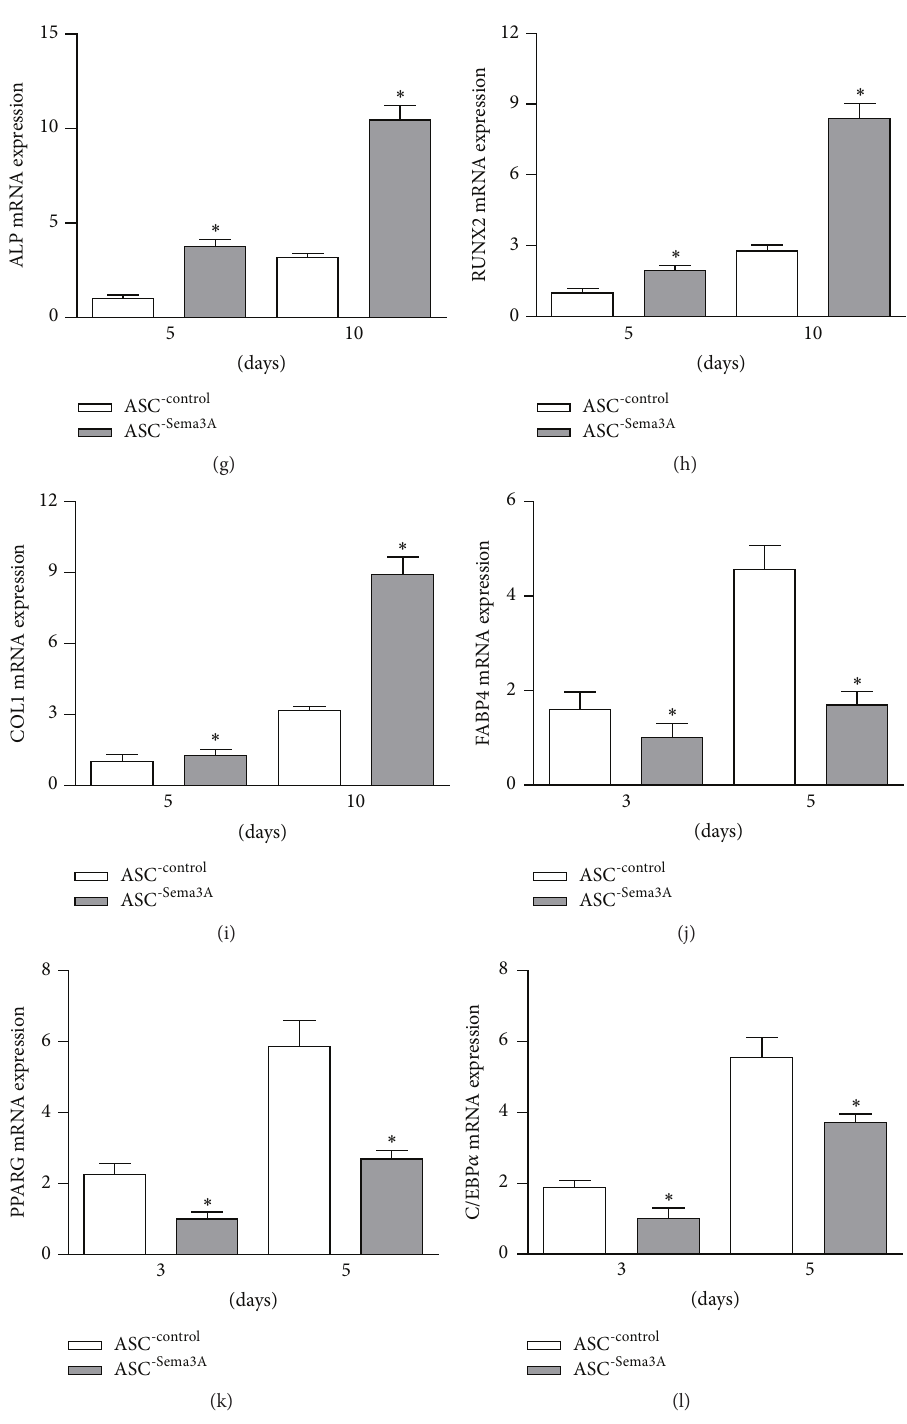
Figure 2: Sema3A promotes osteogenic differentiation while inhibiting adipogenic differentiation in ASCs. (a) ASCs were infected with either empty pWPI or Sema3A overexpression lentivirus, respectively. ASC - Sema 3 A showed higher ALP activity than ASC - control after 7-day osteogenic induction. (b) Quantification data of ALP activity. (c) Significantly more mineralization nodules were found in ASC - Sema 3 A group than that in ASC - control group after 21 days of osteogenic induction. (d) Quantification data of ECM mineralization in Figure 2(c). (e) Sema3A significantly reduced lipid droplet formation in ASCs after 9 days of adipogenic induction. (f) Quantification data of lipid droplets in Figure 2(e). (g, h, and i) Expression of the osteogenesis related genes including ALP, RUNX2, and COL-1 after 5 and 10 days of osteogenic induction. (j, k, and l) Expression of the adipogenesis related genes including FABP4, PPARG, and C/EBPA after 3 and 5 days of adipogenic induction. Mean ± SD, 𝑛 = 3 , and ∗ 𝑝 < 0.05